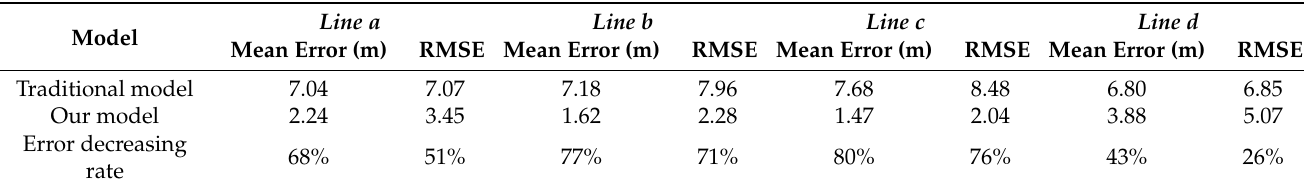
Table 8. Errors statistic using seven check